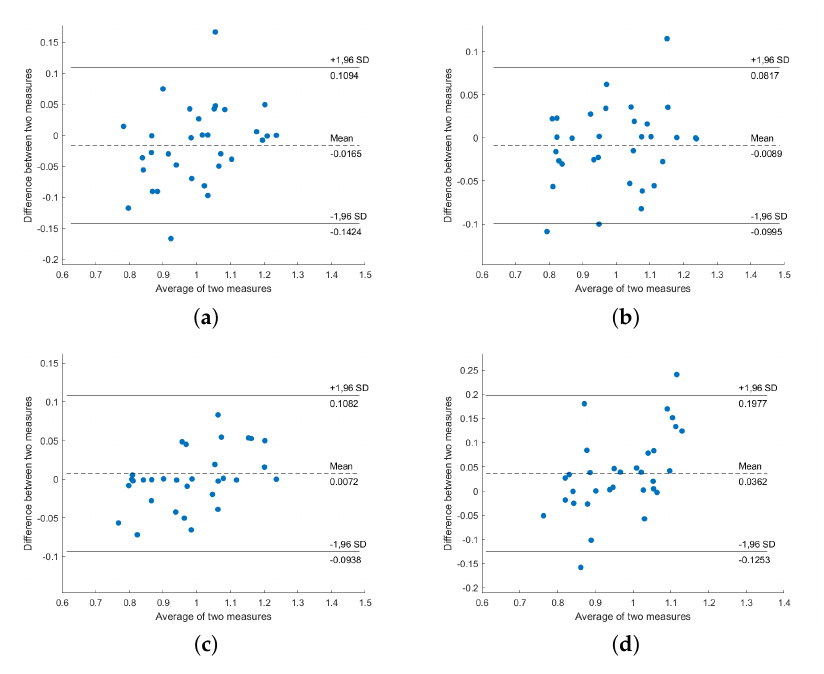
Figure A2. Bland–Altman plot of ECG-HRV and BCG-HRV, position “Left”: ( a ) S1; ( b ) S2; ( c ) S1 and S2; ( d ) all